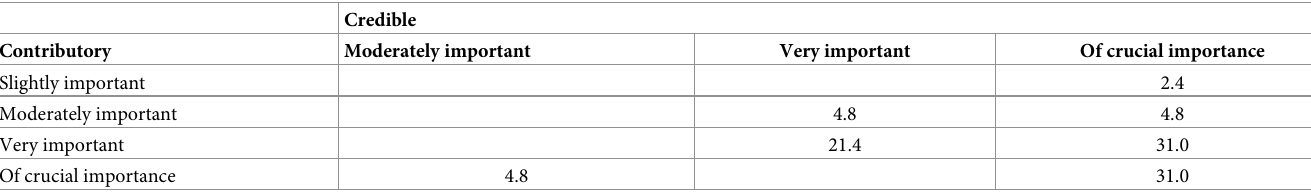
Table 2. Credible and contributory in a 2-way frequency table